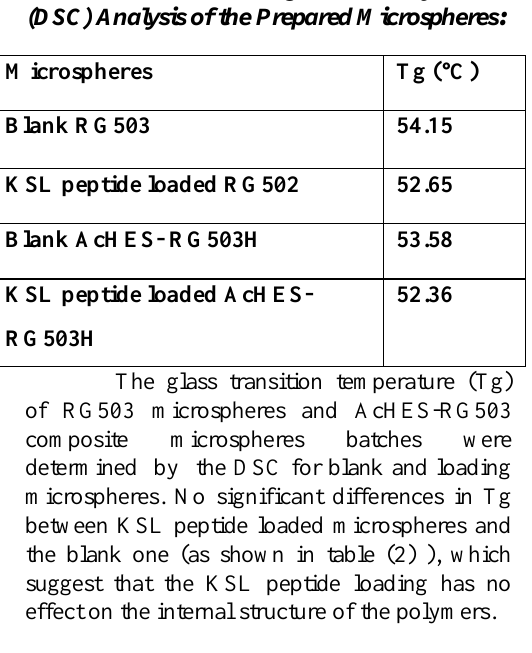
Table 2: The Glass Transition Temperature (Tg) Of Blank An Loaded